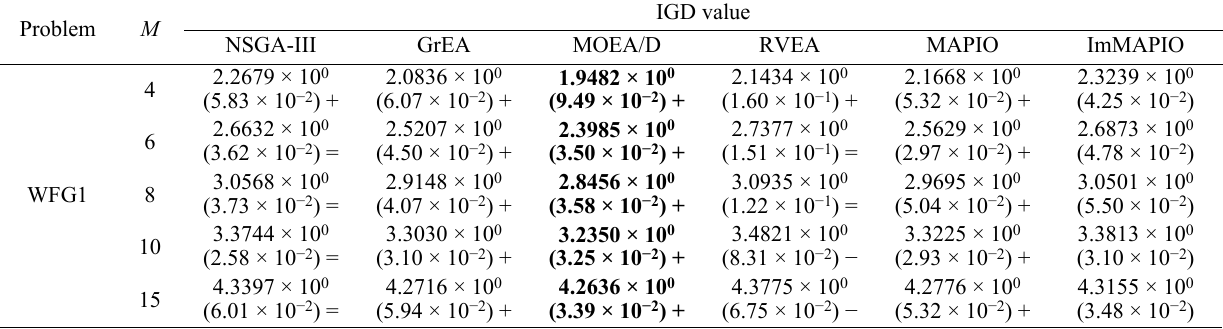
Table 4 IGD values of six algorithms for different objectives in the WFG test